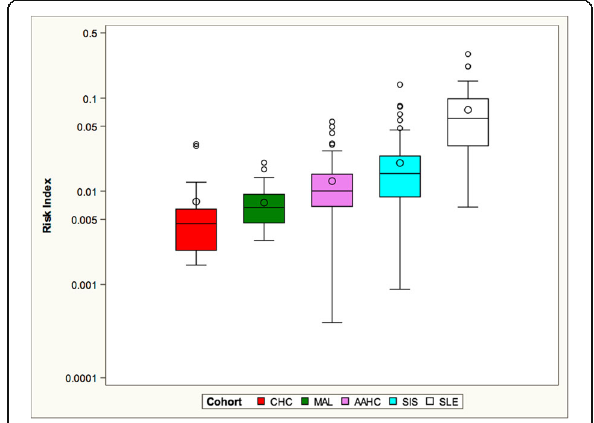
Fig. 5 All cohorts were significantly different from each other, except the CHC and MAL cohorts which showed no significant